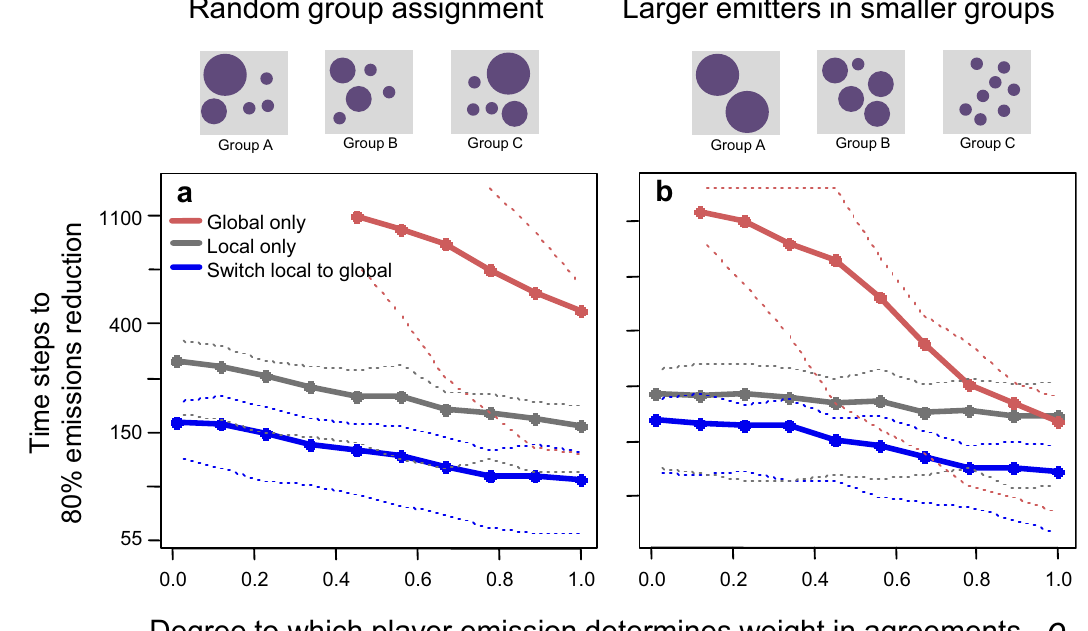
Fig. 4 Greater weight of larger emitters in establishing enforcement-based agreements accelerates world-wide mitigation. This pattern arises both when larger emitters are assigned to groups randomly ( a ) and when larger emitters belong to smaller groups ( b ). Plots compare the time steps to 80% world-wide mitigation reduction when using only global agreements (red), only local agreements (gray), and shifting from local to global agreements once the fraction of emissions mitigated passes T = 0.4 (blue). Panels above plots exemplify differences in player assignment to groups. Solid lines denote means and dotted lines denote the 25th and 75th quantiles across 100 replicate trials; note the log scale y-axis. Mitigation rates are not plotted for global- only agreements at low ρ levels because this strategy failed to produce 80% world-wide mitigation in a majority of trials before time step